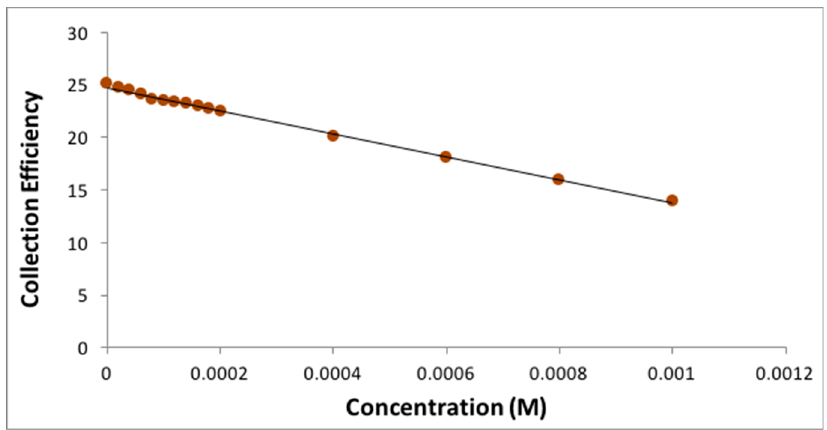
Figure 13. Collection efficiency for eriodictyol.